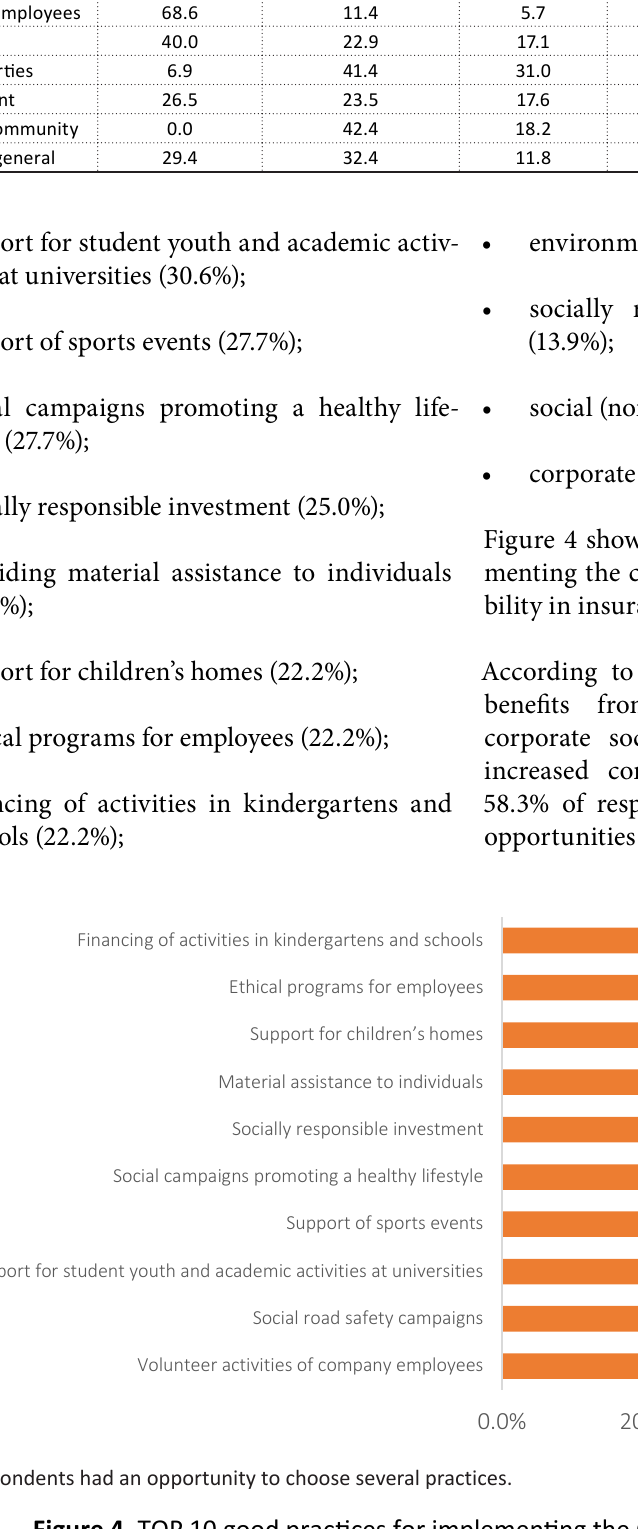
Figure 4. TOP 10 good practices for implementing the CSR concept by